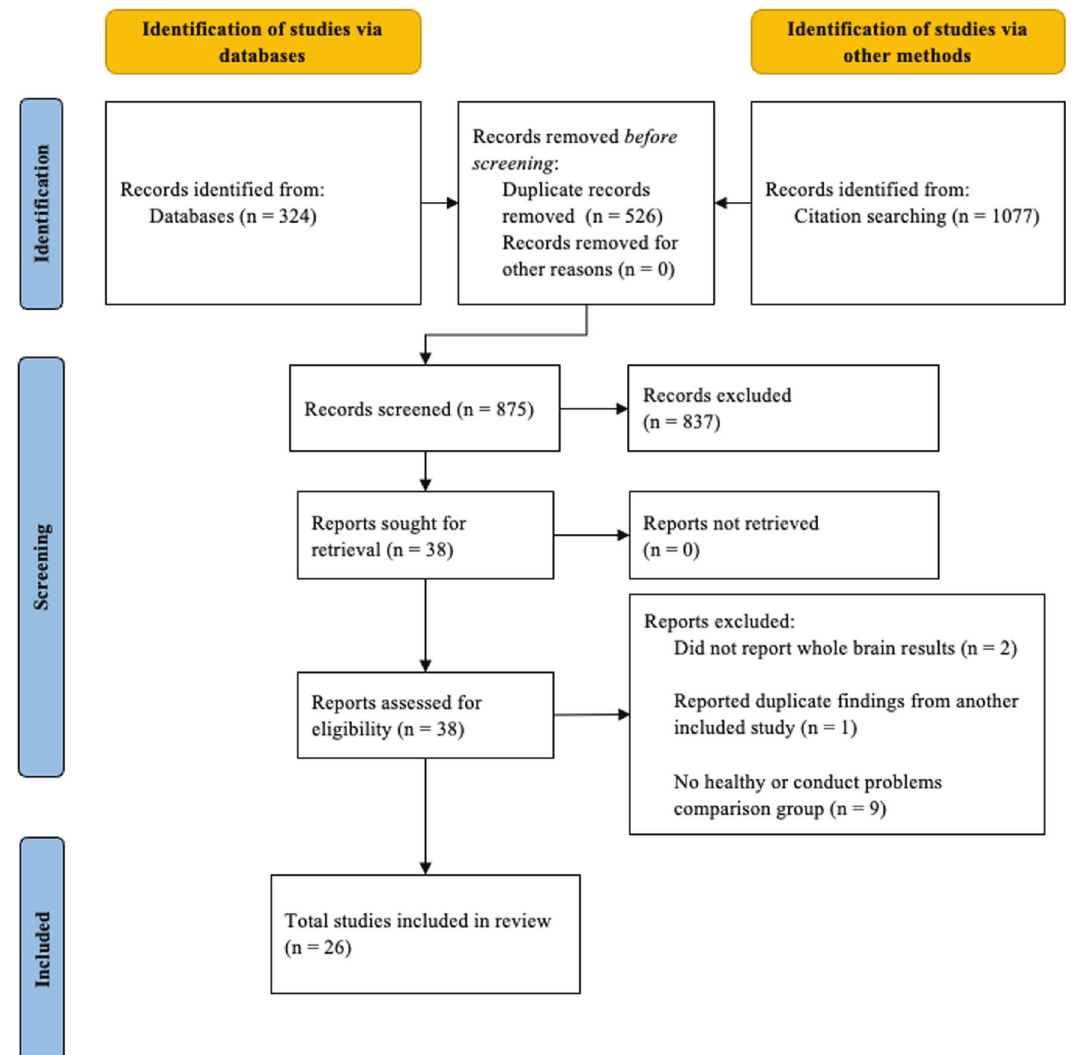
Fig. 1 PRISMA 2020 fl ow diagram. After studies were identi fi ed from a database and citation search, duplicate records were removed. Full text records were screened and studies were excluded (837 studies) that summarized the literature and did not report new fi ndings, we not within the age range, did not use task based fMRI to measure emotion processing, did not investigate conduct problems, or were case studies. Additional screening excluded studies that did not report whole brain results (2 studies), reported duplicate fi ndings from an already included study (1 study), did not have a healthy or conduct problems comparison group (9